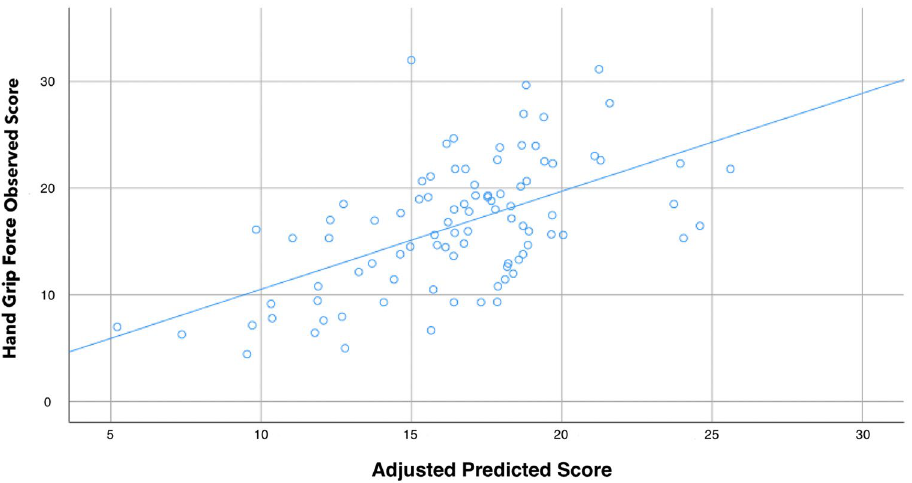
Figure 1. Scatter plot of the adjusted predicted score (r 2 adjusted: 0.344) explaining Hand Grip Force score in female patients with fibromyalgia